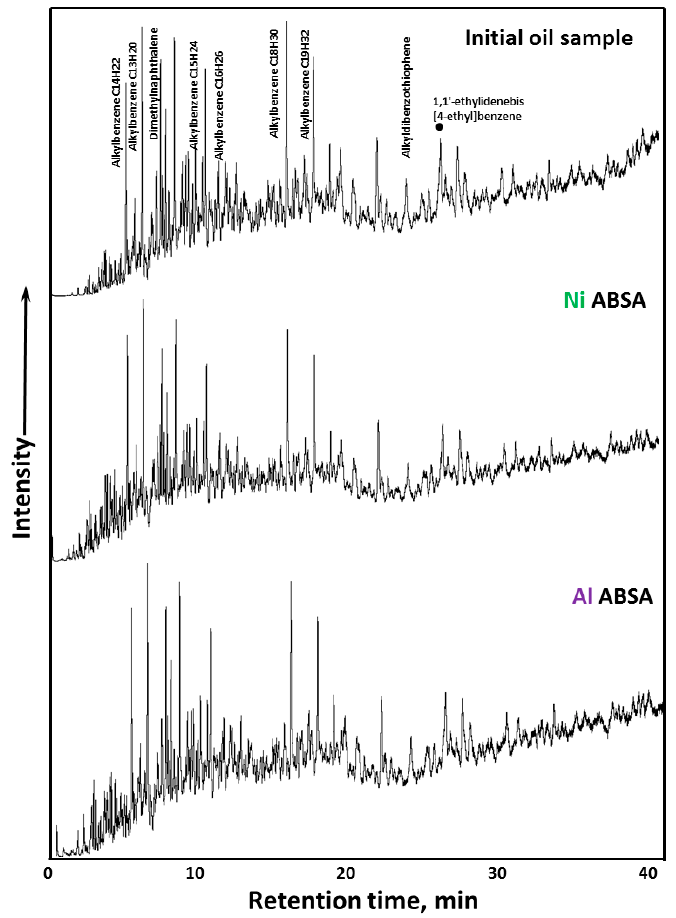
Figure 10. The GC–MS spectra (TIC) of aromatics isolated from crude oil samples.